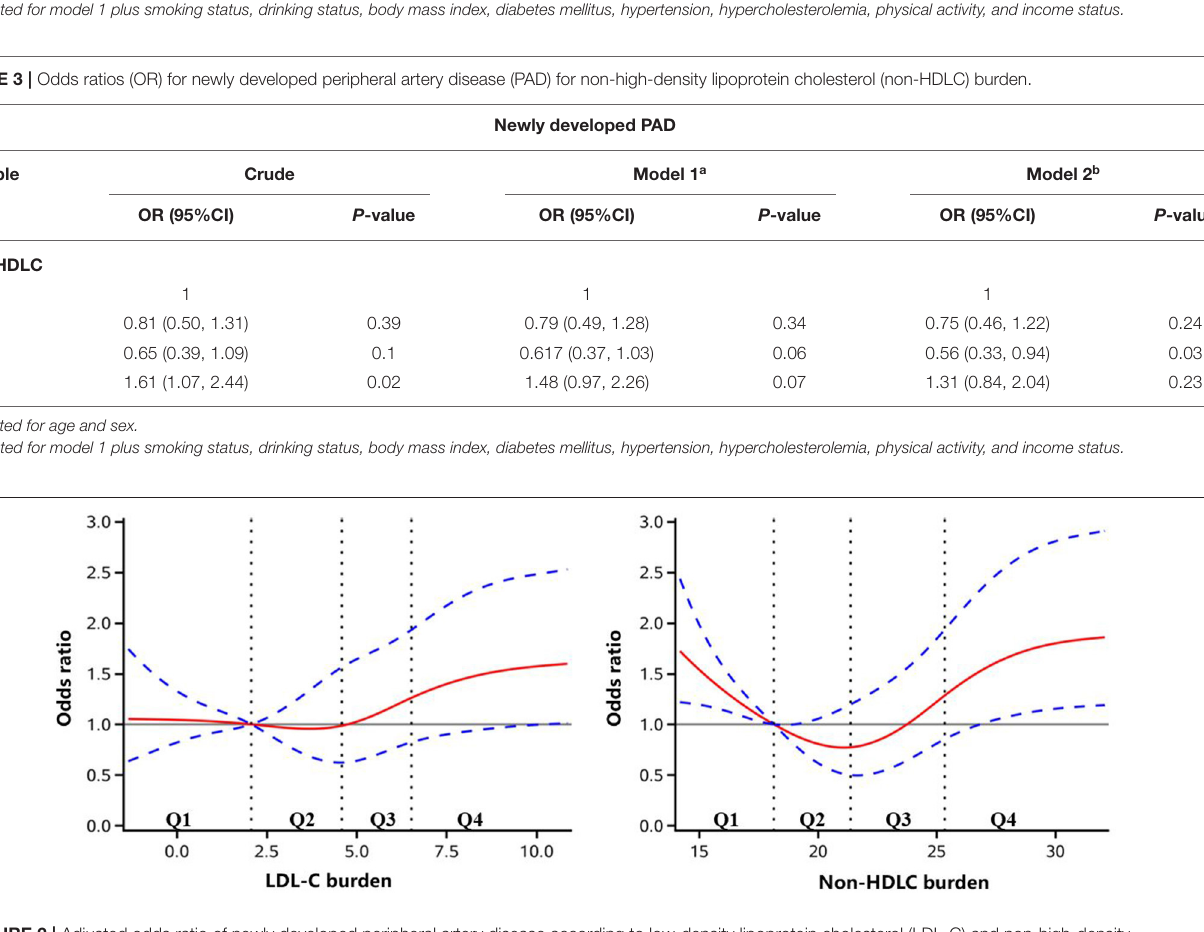
FIGURE 2 | Adjusted odds ratio of newly developed peripheral artery disease according to low-density lipoprotein cholesterol (LDL-C) and non-high-density lipoprotein cholesterol (non-HDLC) burden. The red lines indicate adjusted odds ratio, and the blue dotted line indicate the 95% confidence interval bands. The reference is Q1 of LDL-C and non-HDLC burden. The data were fitted with a logistic regression model of restricted cubic spline with five knots (5, 25, 50, 75, and 95th percentiles) for LDL-C and non-HDLC burden, with adjustment for age, sex, smoker, drinker, body mass index, diabetes mellitus, hypertension, hypercholesterolemia, physical activity, and income status. The lowest 5% and highest 5% of the participants were not shown for small sample